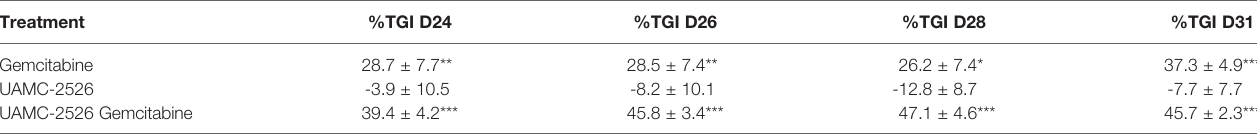
TABLE 1 | Percentage tumor growth inhibition (%TGI) of Panc02 tumors after 24-31 days (D24-D31) of treatment. Treatment Gemcitabine